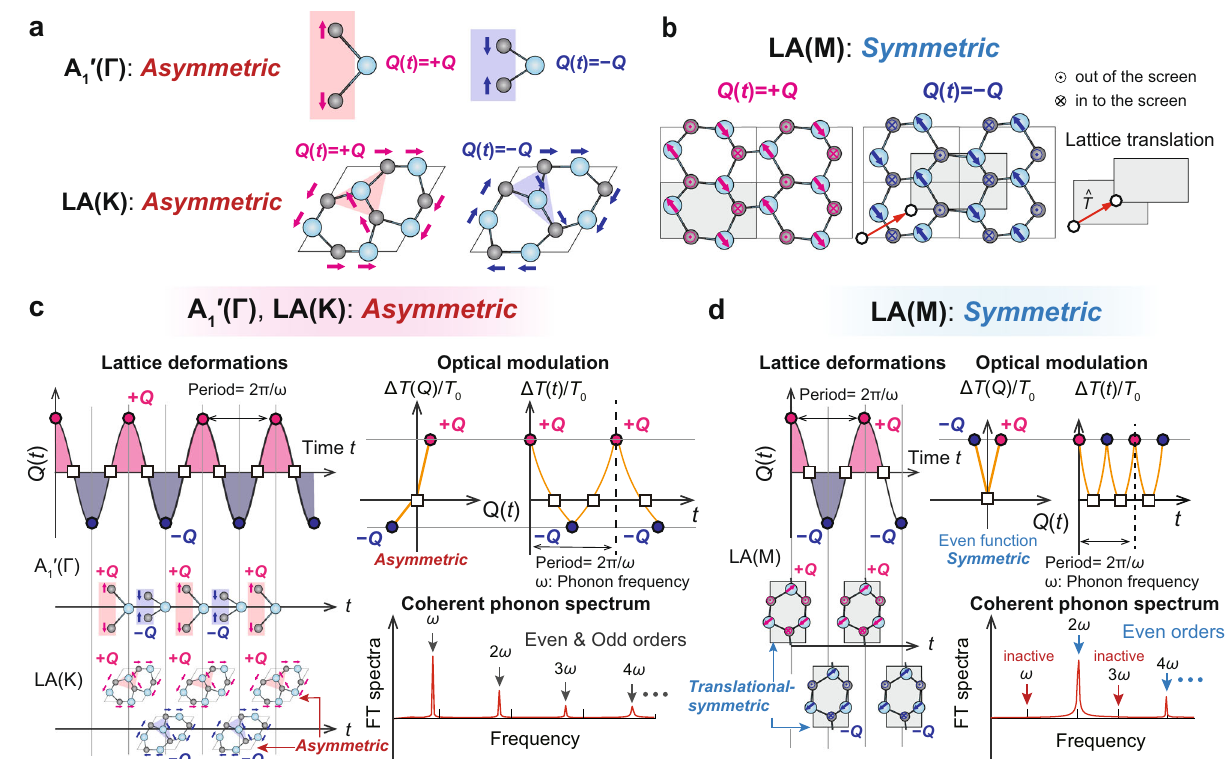
Fig. 2 | Lattice deformations of the A 1 ′ ( Γ ), LA(K), and LA(M) modes in TMDCs and their optical modulations (e.g., differential transmittance Δ T/T 0 ) asso- ciated coherent phonon (CP) spectra. a Asymmetric lattice deformations of the A 1 ′ ( Γ ) and LA(K) modes. Q ( t ) represents the atomic displacements oscillating over time. The + and − signs of Q ( t ) denote the directions of vibrations. Lattice defor- mations of the A 1 ′ ( Γ ) and LA(K) modes are asymmetric because the atomic struc- tures with + Q and − Q displacements are not identical. b Symmetric lattice deformations of the LA(M) mode. In contrast with the asymmetric A 1 ′ ( Γ ) and LA(K)